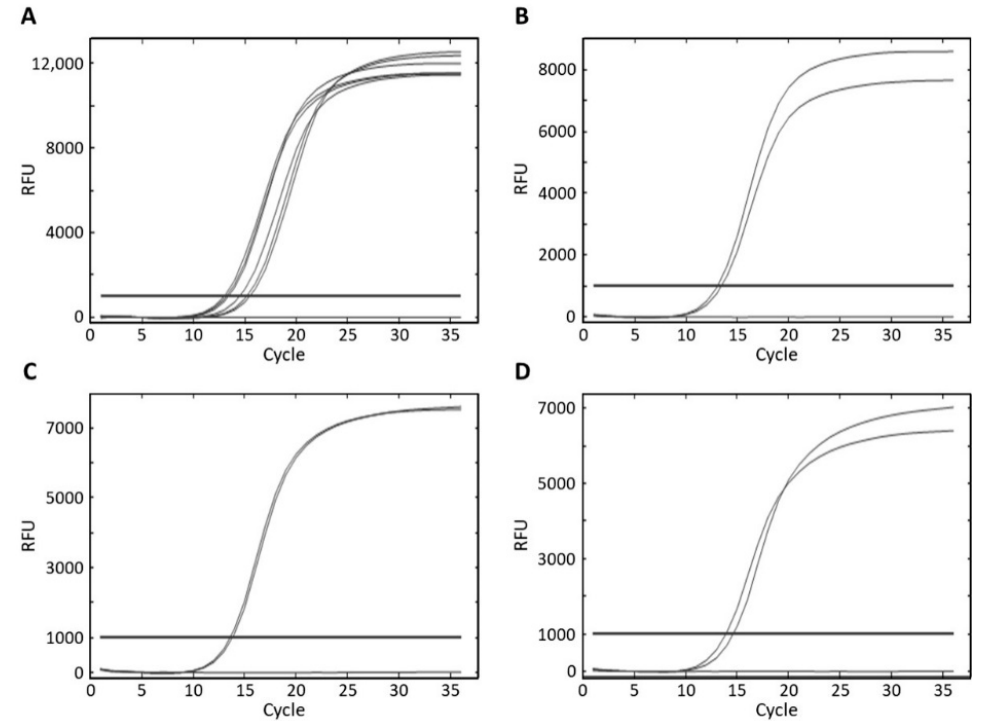
Figure 2. Specificity of the primer pairs for real-time PCR amplification. ( A ) S. aureus ATCC 29213, KCTC 1928, NCCP 14560, ATCC25923, ATCC 29737, and ATCC 6538 amplified using the S. aureus primer pair; ( B ) S. capitis NCCP 14663 and KACC 13242 amplified using the S. capitis primer pair; ( C ) S. caprae KCTC 3583 and NCCP 15629 amplified using the S. caprae primer pair; ( D ) S. epidermidis NCCP 14723 and KACC 13234 amplified using the S . epidermidis primer pair.